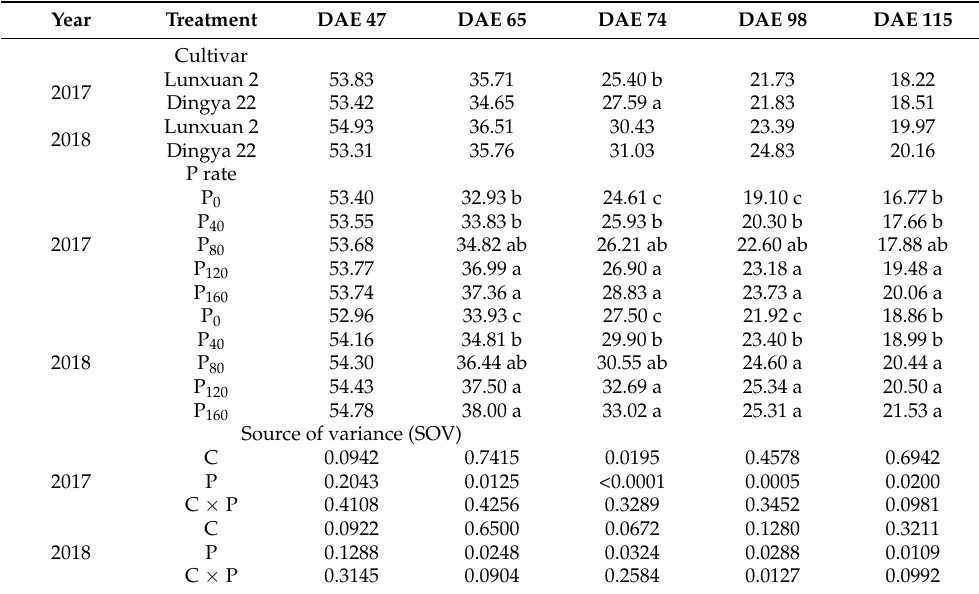
Table 5. Shoot N concentration (g kg − 1 DM) at Dingxi in 2017 and 2018 with two cultivars flax and five phosphorus rates.